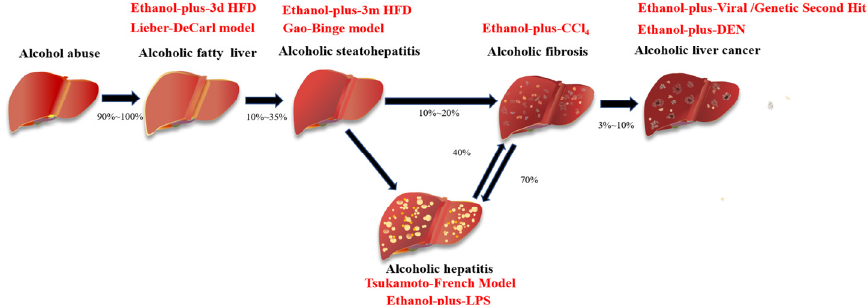
Figure 1. Commonly used experimental models for various stages of ALD. Ethanol-plus-3d HFD, ethanol-plus-three days high-fat diet; Ethanol-plus-3m HFD, ethanol-plus-three months high-fat diet; Ethanol-plus-CCl4, ethanol-plus-carbon tetrachloride; Ethanol-plus-DEN, ethanol-plus-N-Nitrosodiethylamine; Ethanol-plus-LPS, ethanol-plus-lipopolysaccharide.